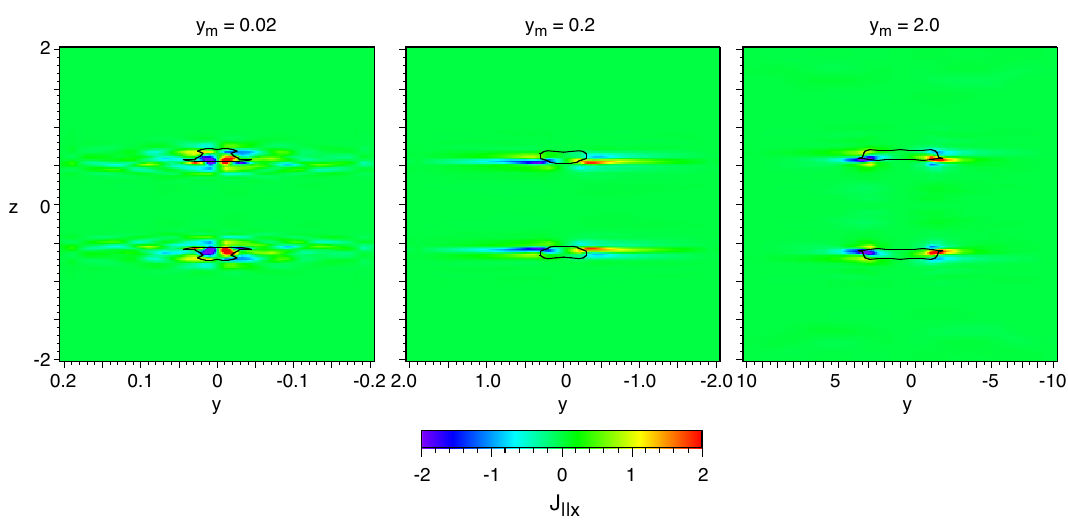
Fig. 17. Field-aligned current densities j k x at x =− 1 near the inner (earthward) boundary at t = 20 for three different bubble widths. The black contours outline the bubble flux